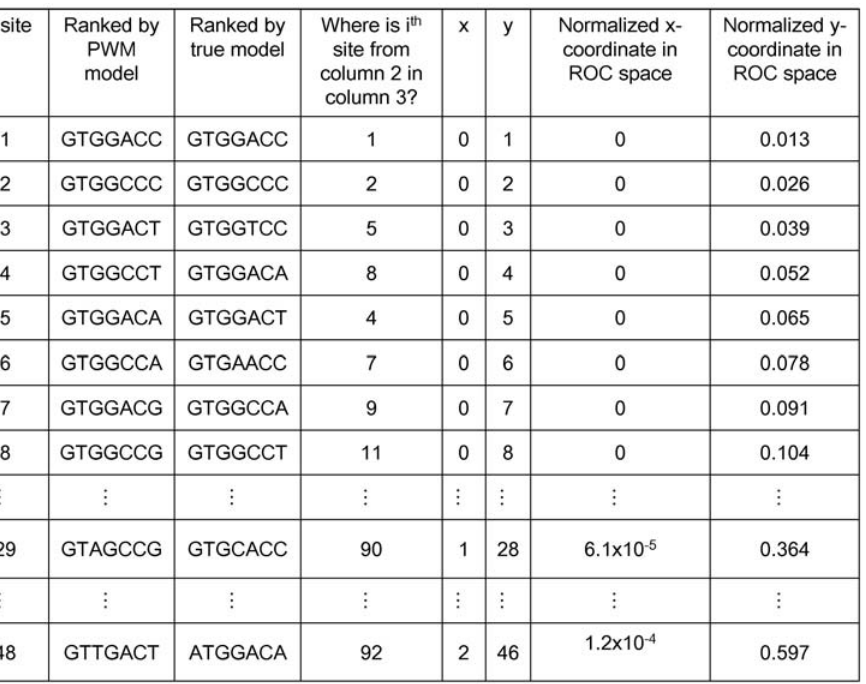
Figure 7. Creating a ROC curve. This figure shows a portion of a typical spreadsheet used to construct a ROC curve. In this example the PWM model is a log-odds model based on 50 sites. The cutoff is 4 and the sampling mode is Boltzmann. There are 77 sites whose true energy is below or equal to the cutoff (i.e. K=77). In the original spreadsheet the index i runs from 1 to 16,384.